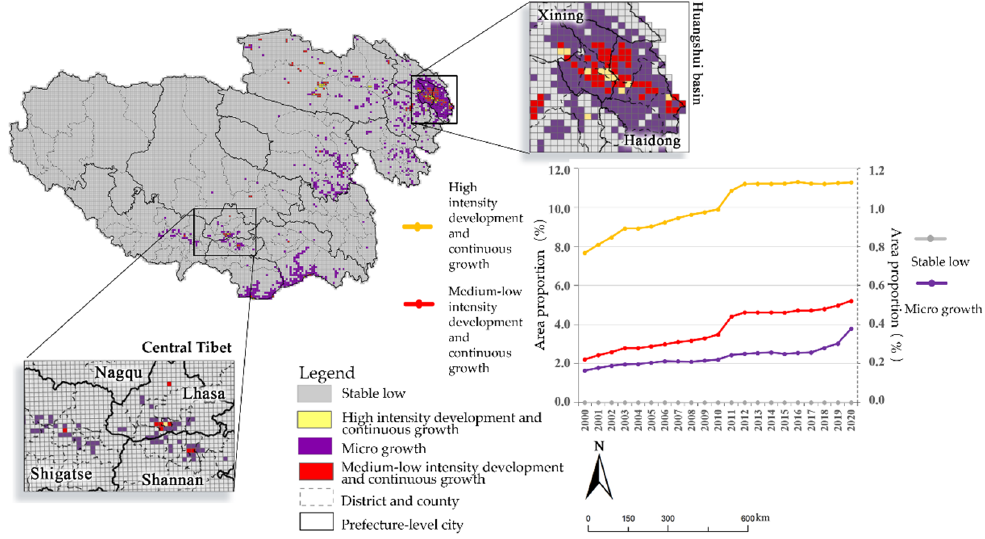
Figure 3. The evolution of the urbanization